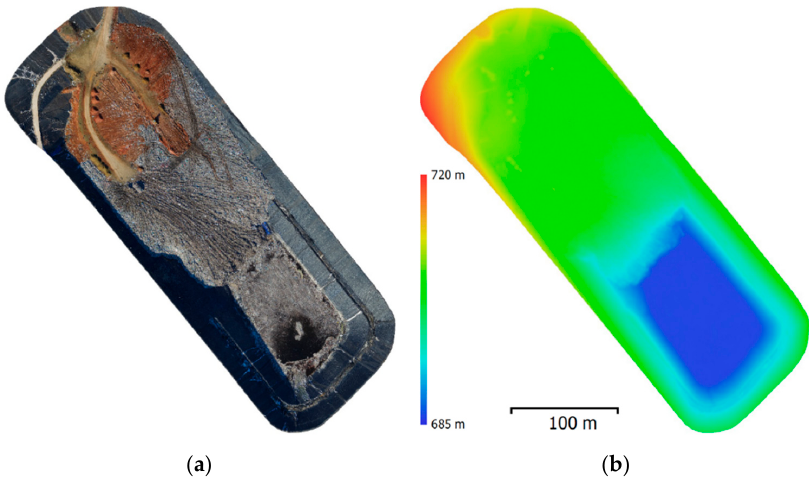
Figure 5. ( a ) Clipped tiled model which includes only the storage area; ( b ) clipped DEM corresponding to the clipped tiled model.